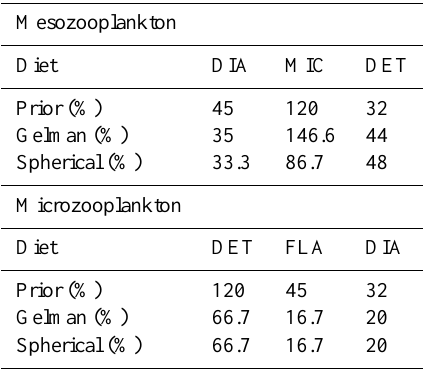
Table 2. Zooplankton grazing preferences (π i ) i = 1 : 3 : relative RMS error (computed over the 20 experiments) of the means of prefer- ences obtained at the final